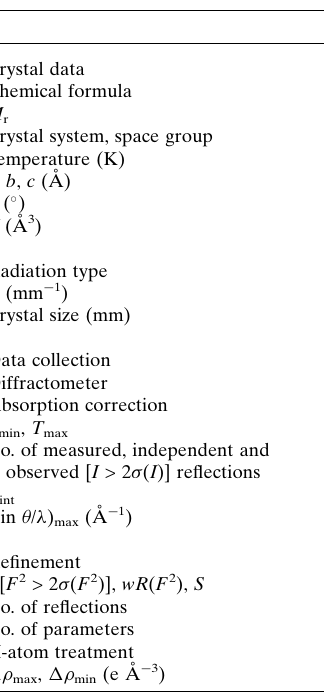
Table 4 Experimental details.